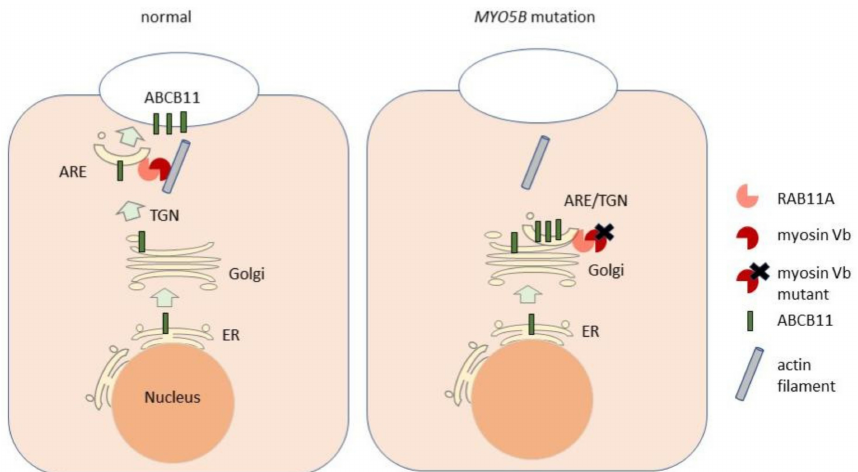
Figure 5. Cartoon depicting the role of myosin Vb and mutant myosin Vb in the trafficking of ABCB11. In the normal situation (left) newly synthesized ABCB11 traffics via the endoplasmic reticulum (ER), the Golgi apparatus and the trans- Golgi network (TGN) to the apical recycling endosomes (ARE). From the ARE, ABCB11 is trafficked to the bile canalicular surface via a mechanism that involves the interaction between the ARE-associated RAB11A and the myosin Vb protein, the latter of which interacts with actin filaments. In the presence of a mutant form of myosin Vb (right), ABCB11 is trapped in a compartment that contains RAB11A, the mutant myosin Vb protein and markers of the TGN, and fails to reach the bile canalicular surface (see also